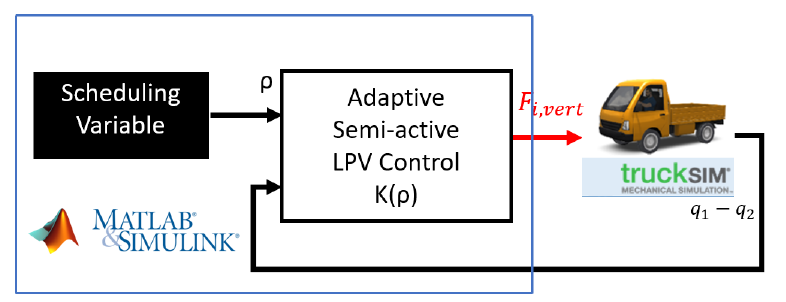
Figure 8. The architecture of a system. Adaptivity of the introduced controller is demonstrated with three different road irregularities, which are random road roughness, sine-sweep road irregularity, and several 5 cm bumps. The sine-sweep road irregularity represents a typical road at the bus stop due to its rolled-up structures with longitudinal sinusoidal road distortion with growing frequency, see Figure 9a. The length of this irregularity is 83 m. The several bumps irregularities consist of different bumps following each other, with 5 cm height, to represent the poor road quality with discontinuities in the asphalt, while its length is 22 m, see Figure 9b. The road roughness represents the general road roughness in the asphalt, and this irregularity is shown in Figure 9c. Roughness of 92 m is applied to the simulation.